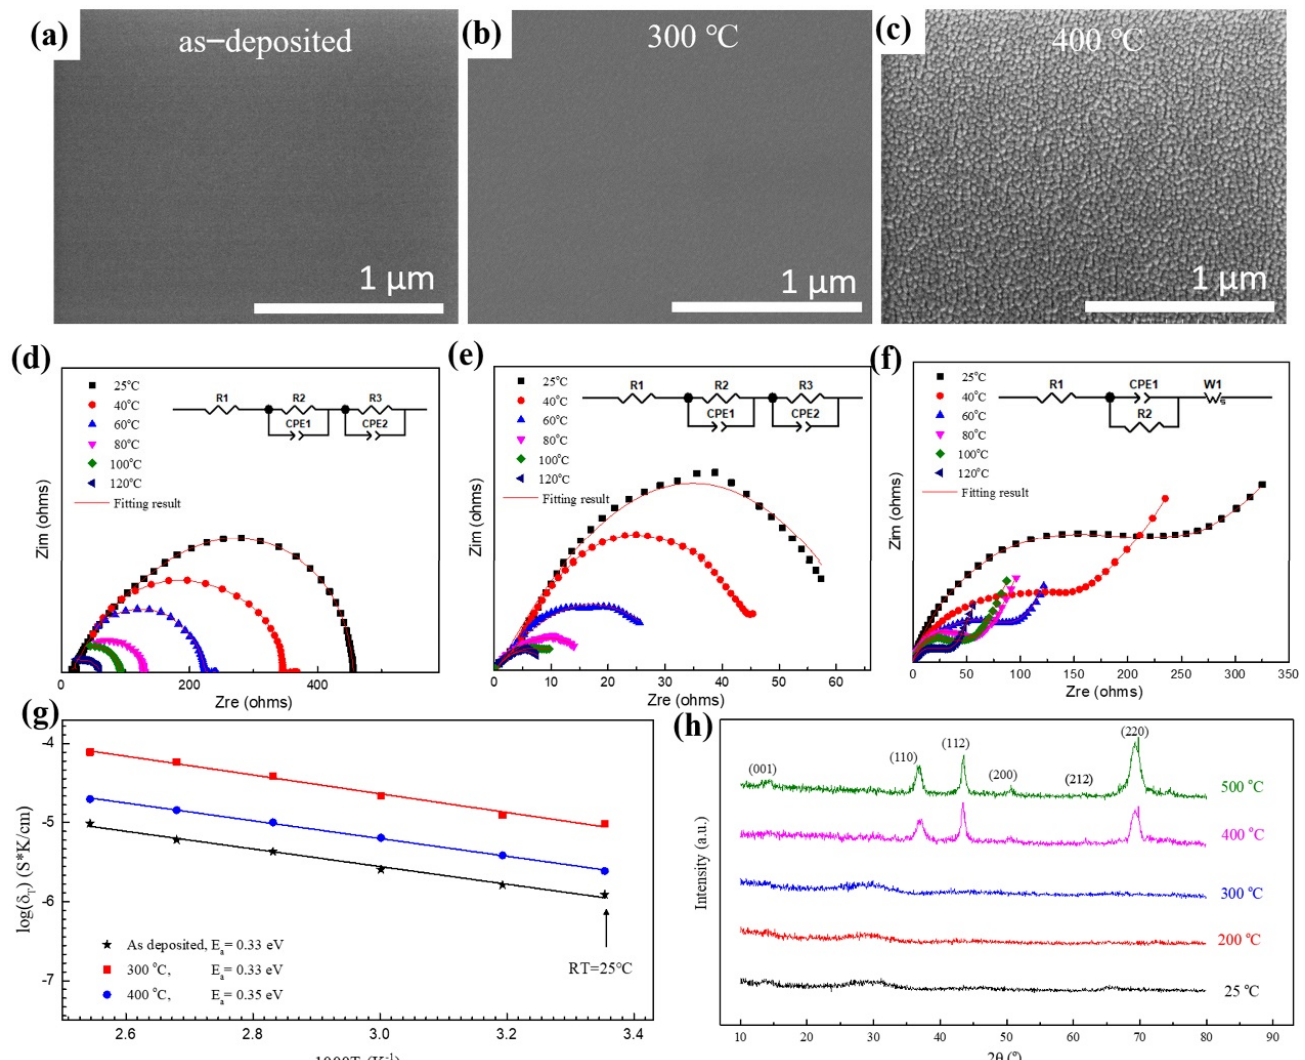
Figure 1. Microstructure and electrochemical properties of LLTO solid electrolyte thin films. Plane ‐ view scanning electron microscopy (SEM) images of LLTO thin film annealed at different temperature: ( a ) as − deposited, ( b ) 300 °C, ( c ) 400 °C. Electrochemical impedance spectroscopy (EIS) measurements of the LLTO annealed at different temperature (inset is the equivalent circuit diagram): ( d ) as − deposited, ( e ) 300 °C, ( f ) 400 °C. ( g ) Arrhenius plots in the temperature range from 25 to 120 °C with an interval of 20 °C. ( h ) X ‐ ray diffraction (XRD) data of LLTO thin films.